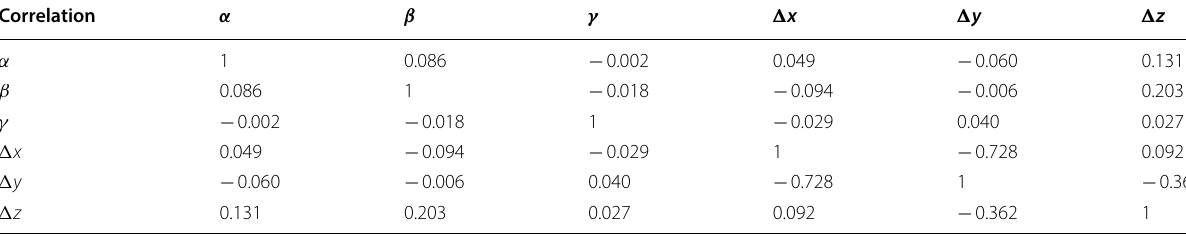
Table 2 Correlation coefficient matrix of α , β , γ , � x , � y , � z Correlation